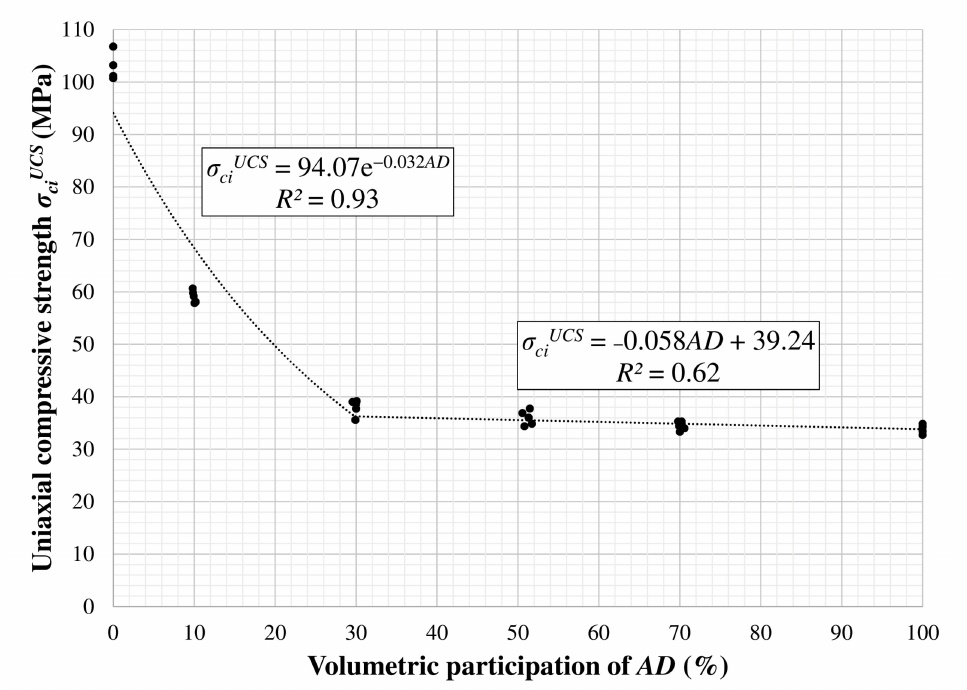
Figure 8. UCS results ( σ ciUCS ) for different participation of